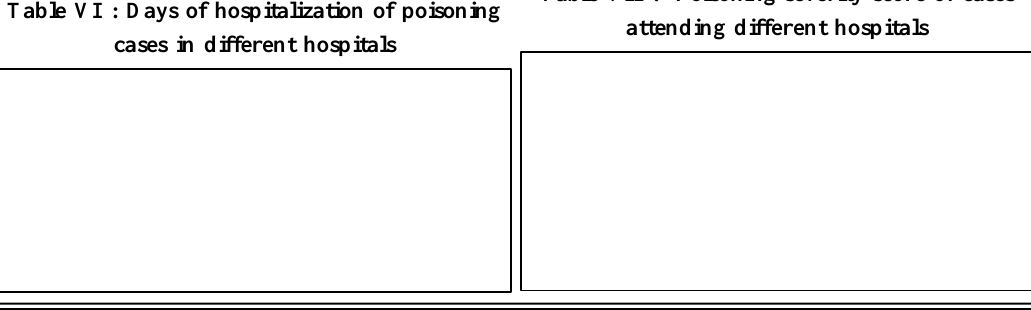
Table VII : Poisoning severity score of